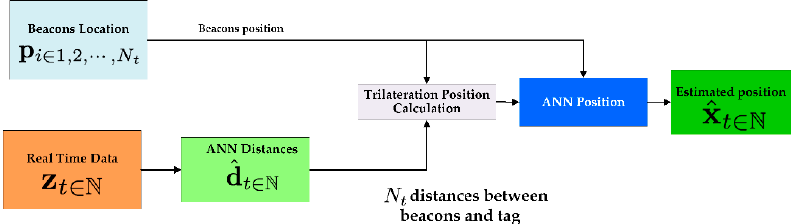
Figure 4. Architecture of the Multi-Layer Perceptron Neural Network used to calculate the distance